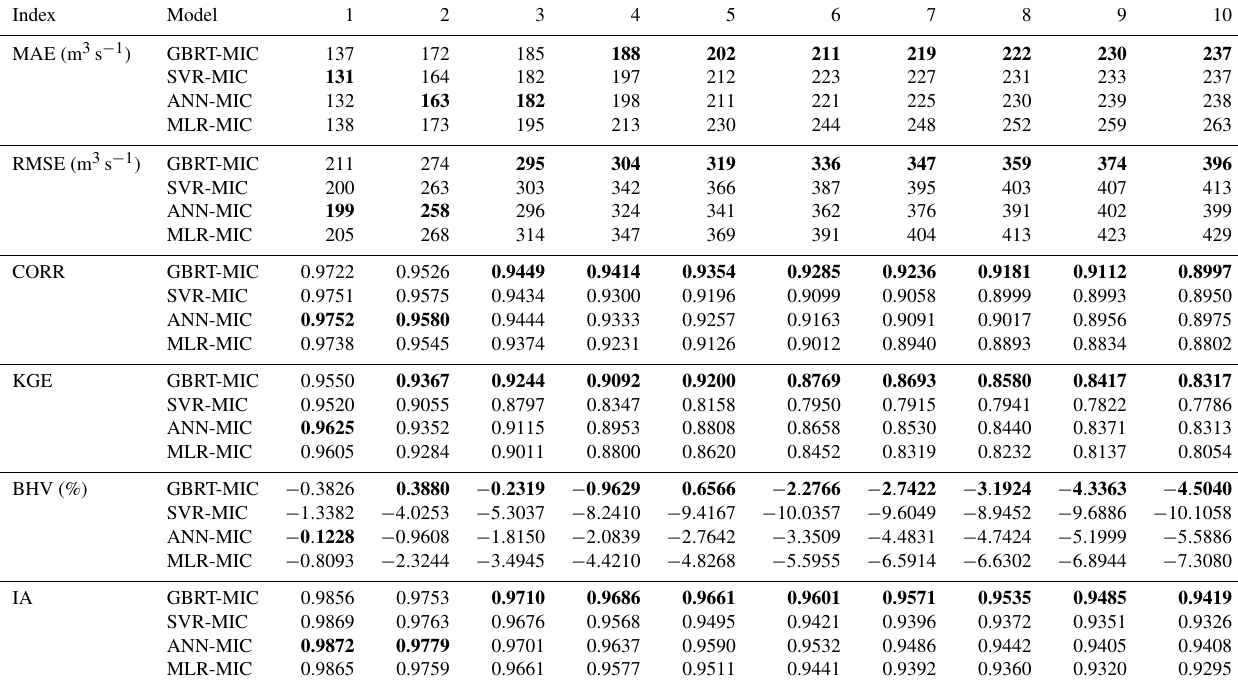
Table 8. Performance indices of the testing set.